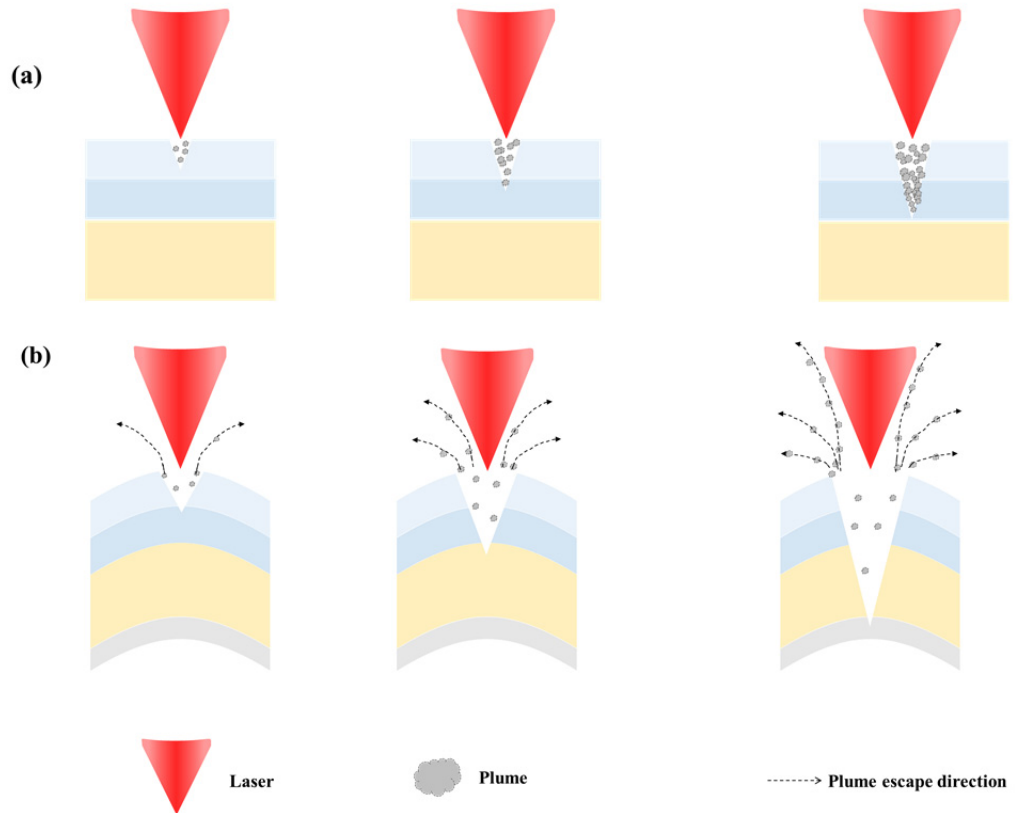
Figure 7. Enhancement of laser ablation by curvature of polymer produced through preliminary preparation (exhaust of plume produced) ( a ) conventional laser ablation ( b ) proposed method.